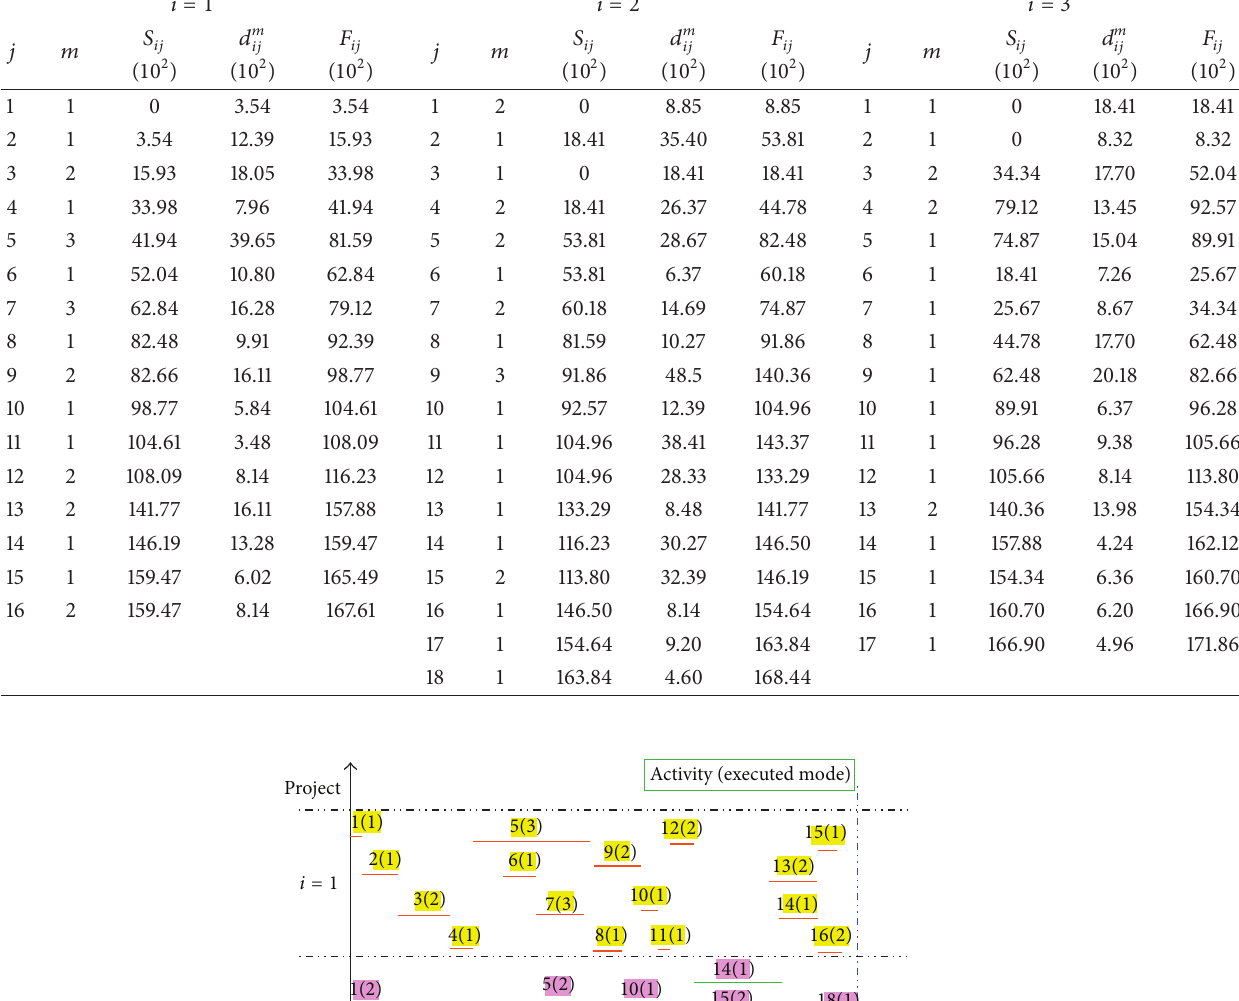
Table 9: Results of the CP-based HPSO algorithm for MRCMPSP.